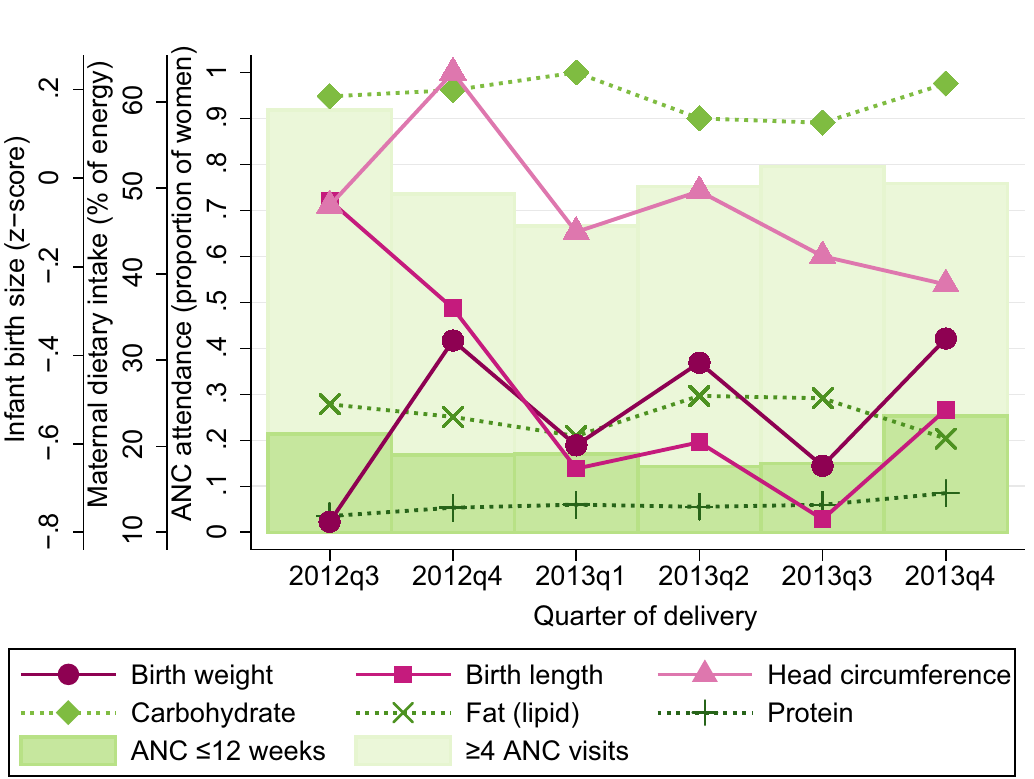
Fig 1. Maternal dietary intake, antenatal care attendance, and infant birth size across the study period, VHEMBE study, South Africa, 2012–2013. Data are means by quarter-year of delivery for maternal carbohydrate, fat, and protein intake as a percentage of total energy in the past month; proportion attended ANC � 12 weeks gestation and � 4 total ANC visits during pregnancy; and birth weight, length, and head circumference z-scores standardized by gestational age and sex.